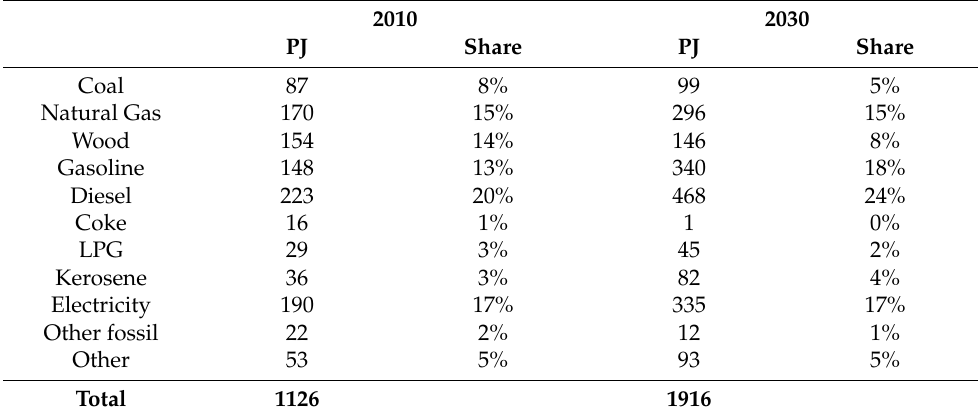
Table 13. Energy demand by energy vector in 2015 and 2030 in the reference